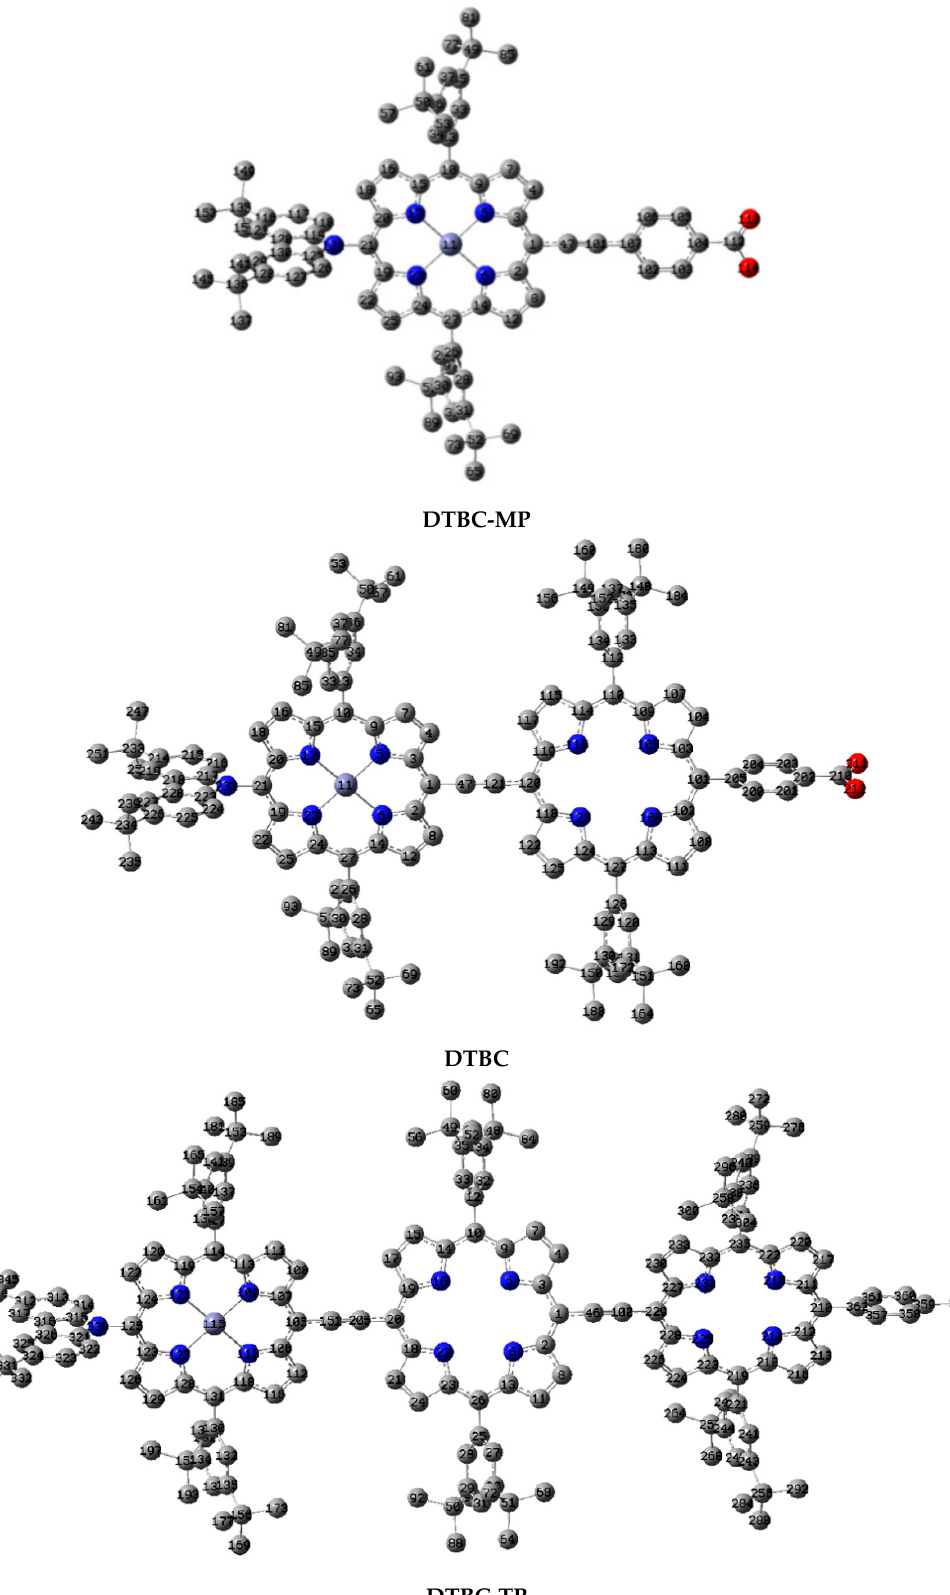
Figure 2. The optimized geometrical structures of DTBC-MP, DTBC, and DTBC-TP (Hydrogen atoms have been omitted for clarity, gray circles: C; blue circles: N; red circles: O; light blue circles: Zn).